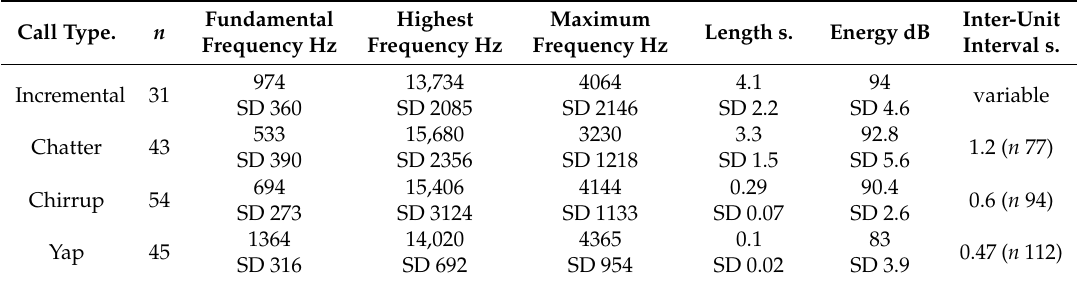
Table 4. Vocal characteristics of Taita Hills Paragalago